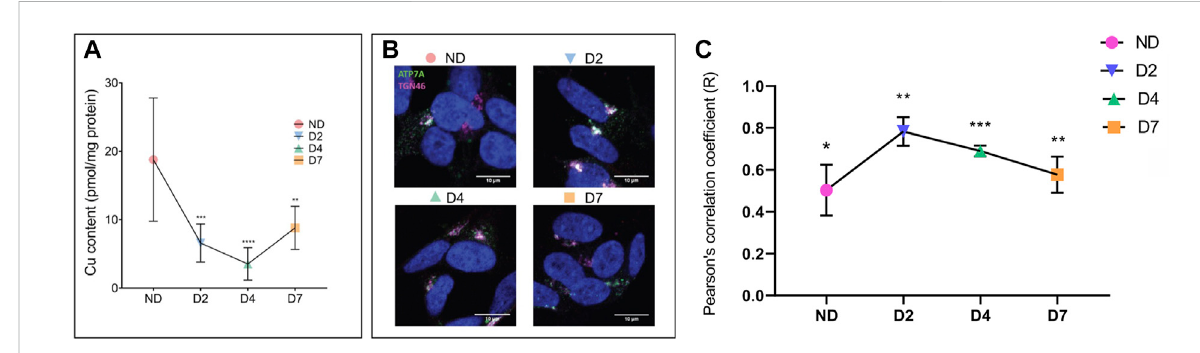
FIGURE 7 Cellular Cu decreases and ATP7A localization changes during neuronal differentiation. SH-SY5Y neuroblastoma cells were differentiated by treatments with RA and BDNF. Cells were collected for analysis on days d0 (non-differentiated, ND), d2 (differentiated d2, D2), d4 (differentiated d4, D4), and d7 (differentiated d7, D7). (A) Atomic absorption spectrometry (AAS) analysis of cellular Cu content. Values normalized to protein content andNDcontrol, n =6. (B) PatternofATP7Astainingand (C) calculationofPiersoncorrelationcoef fi cient(c)illustratestighterTGNlocalizationin response to Cu decrease. ATP7A isstained ingreen, TGN marker TGN46 in pink, and thenucleus (DAPI) inblue. Co-localization between ATP7A and TGN46 is indicated by white color. Pearson ’ s correlation coef fi cient was calculated using Coloc2 plugin of ImageJ software ( n = 3). T-test was performed using Graphpad prism version 9.4.0. Data were represented as Mean ± SD; p -value * p < 0.05, ** p < 0.01, *** p <